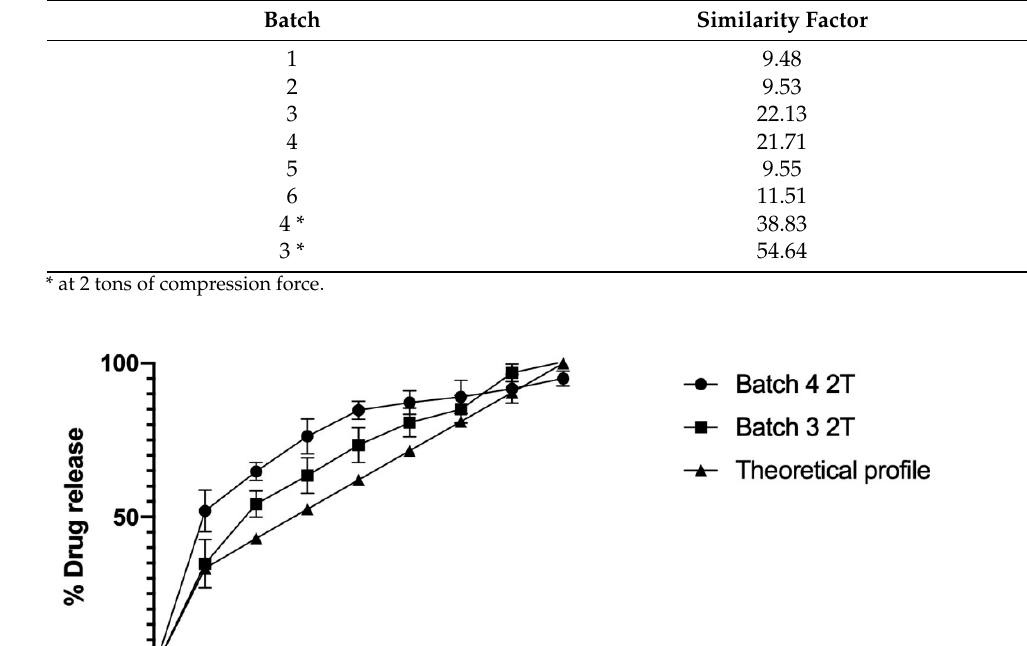
Table 4. Similarity factor (f2) of the dissolution profile of ranitidine chloride for different co-processed systems.